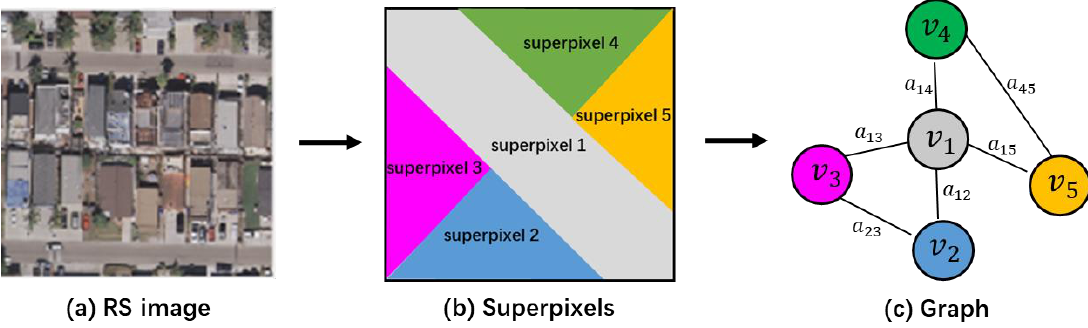
Figure 3. A toy example about the graph construction process. After the unsupervised superpixel segmentation, the remote sensing (RS) image ( a ) consisted of superpixels ( b ), which are regarded as graph nodes ( c ). Additionally, the first-order adjacency relationship (with common edge) between superpixels denotes graph edge ( c ).